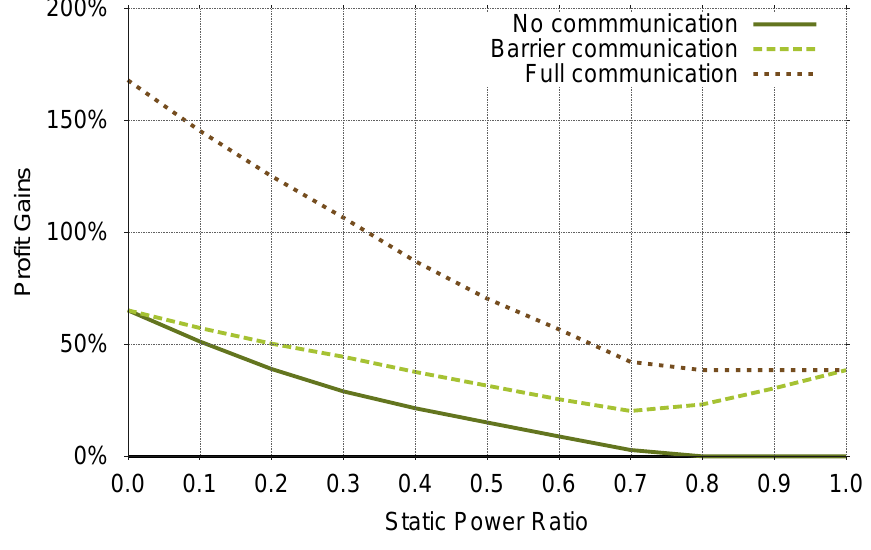
= 1.3 h, t = 2.6 h. R 1 R 2